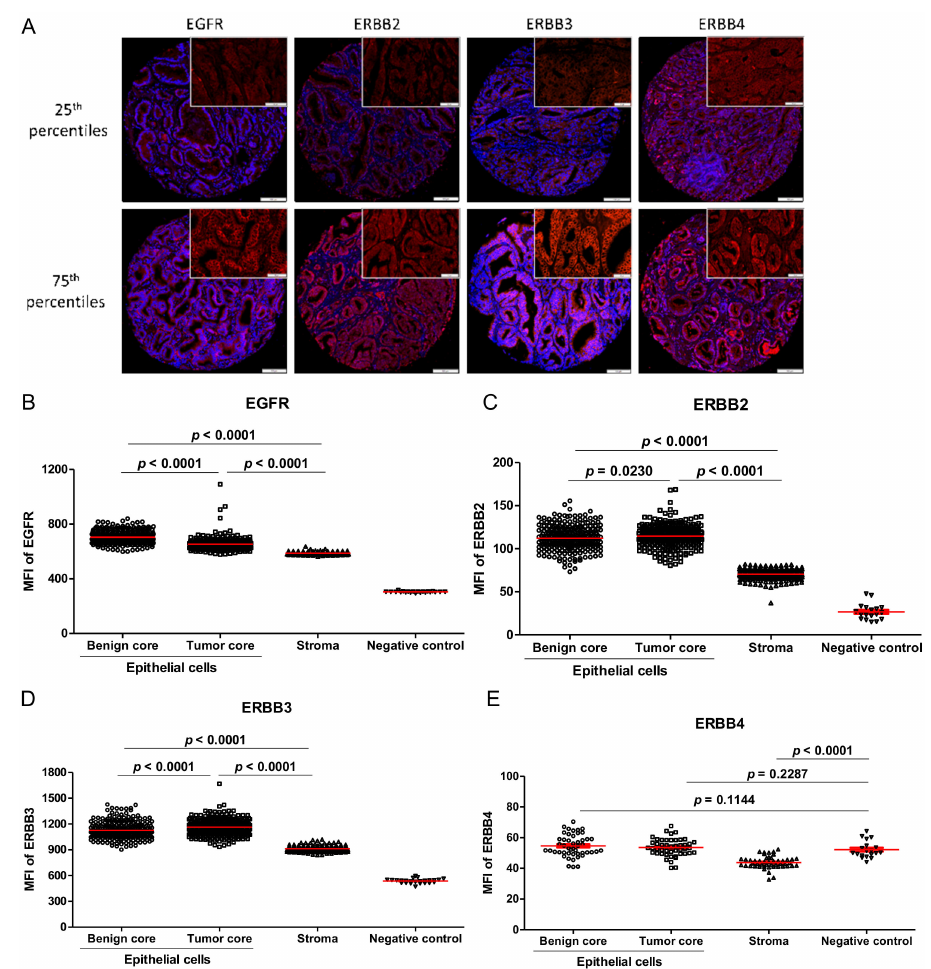
Figure 1. Expression for all ERBB family members in the TF123 TMA series. ( A ) Representative staining of the 25th and 75th percentiles for each protein in epithelial cells of tumor cores. Distribution of ( B ) EGFR, ( C ) ERBB2, ( D ) ERBB3, and ( E ) ERBB4 * expression in the whole PC patient cohort. DAPI (blue) and protein of interest (red). The scale bar at 100 µ m is for the whole image and the scale bar at 50 µ m for enlarged view. * For ERBB4, only one TMA slide was stained and